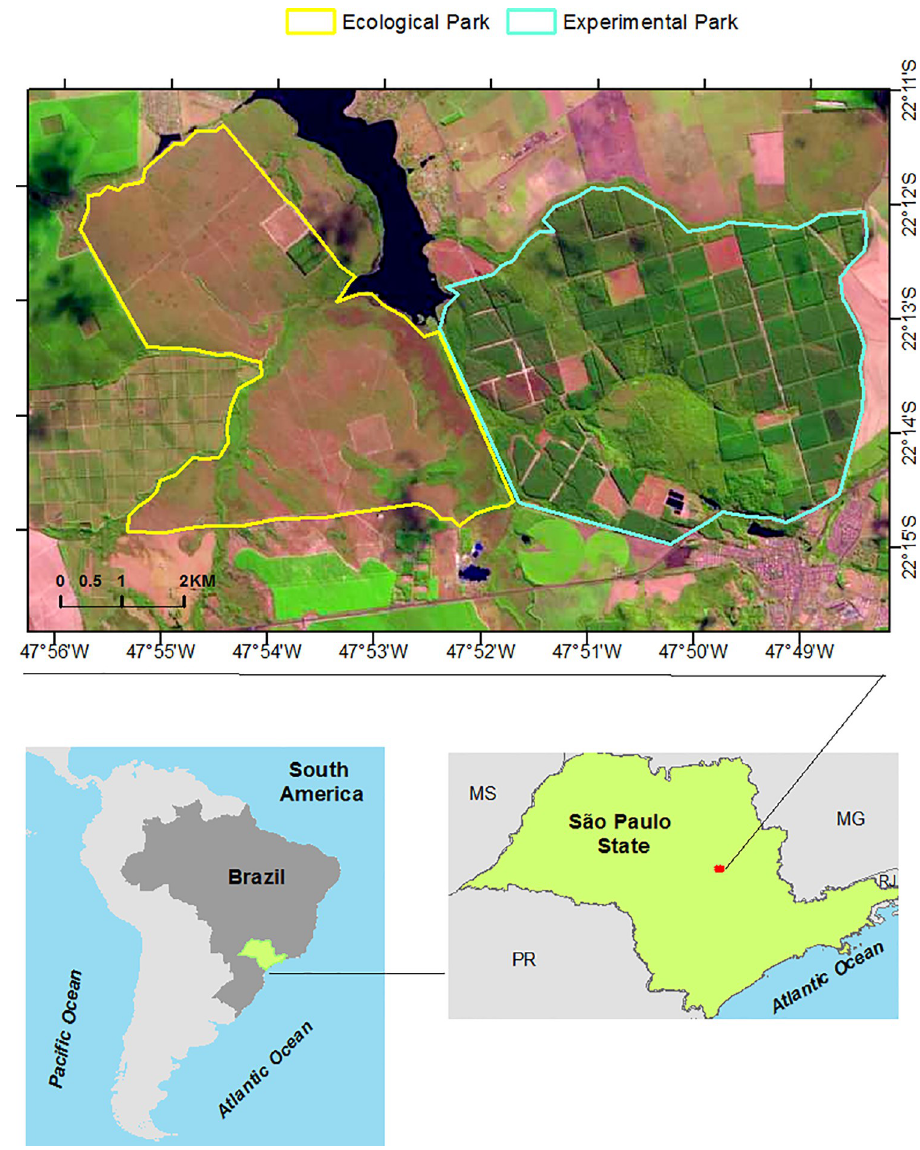
Fig 1. Location of Itirapina’s Ecological and Experimental Parks, S ã o Paulo-Brazil. (Sentinel-2 (ESA) image courtesy of the U.S. Geological Survey).